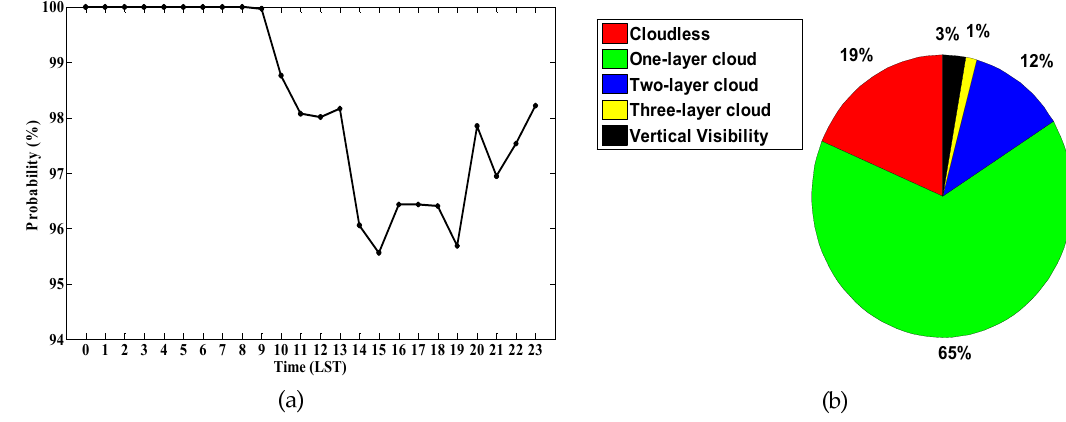
Figure 5. CL31 ( a ) Data acquirability; and ( b ) the probability distribution of cloudless ( red ), one-layer cloud ( green ), two-layer cloud ( blue ), three-layer cloud ( yellow ) and vertical visibility ( black ) during the experiment period.